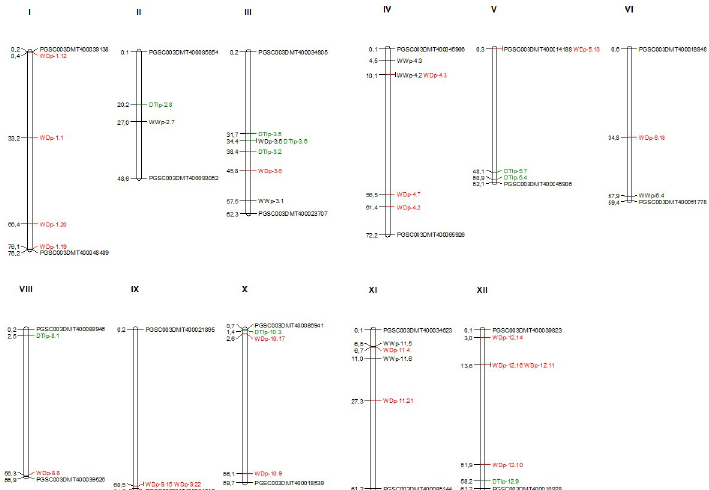
Fig 4. SNPs identified and mapped in the potato chromosomes of Group Phureja. Genomic distances are given in Mbp according to the PGSC V4.03 pseudomolecules [15]. In red are presented the QTL detected in the phenotypic response for water deficit condition, black presented those detected for well- watered conditions, in green are presented those detected for DTI. In black are presented the markers that limit each chromosome in the potato genome. Diagram plotted using MapChart